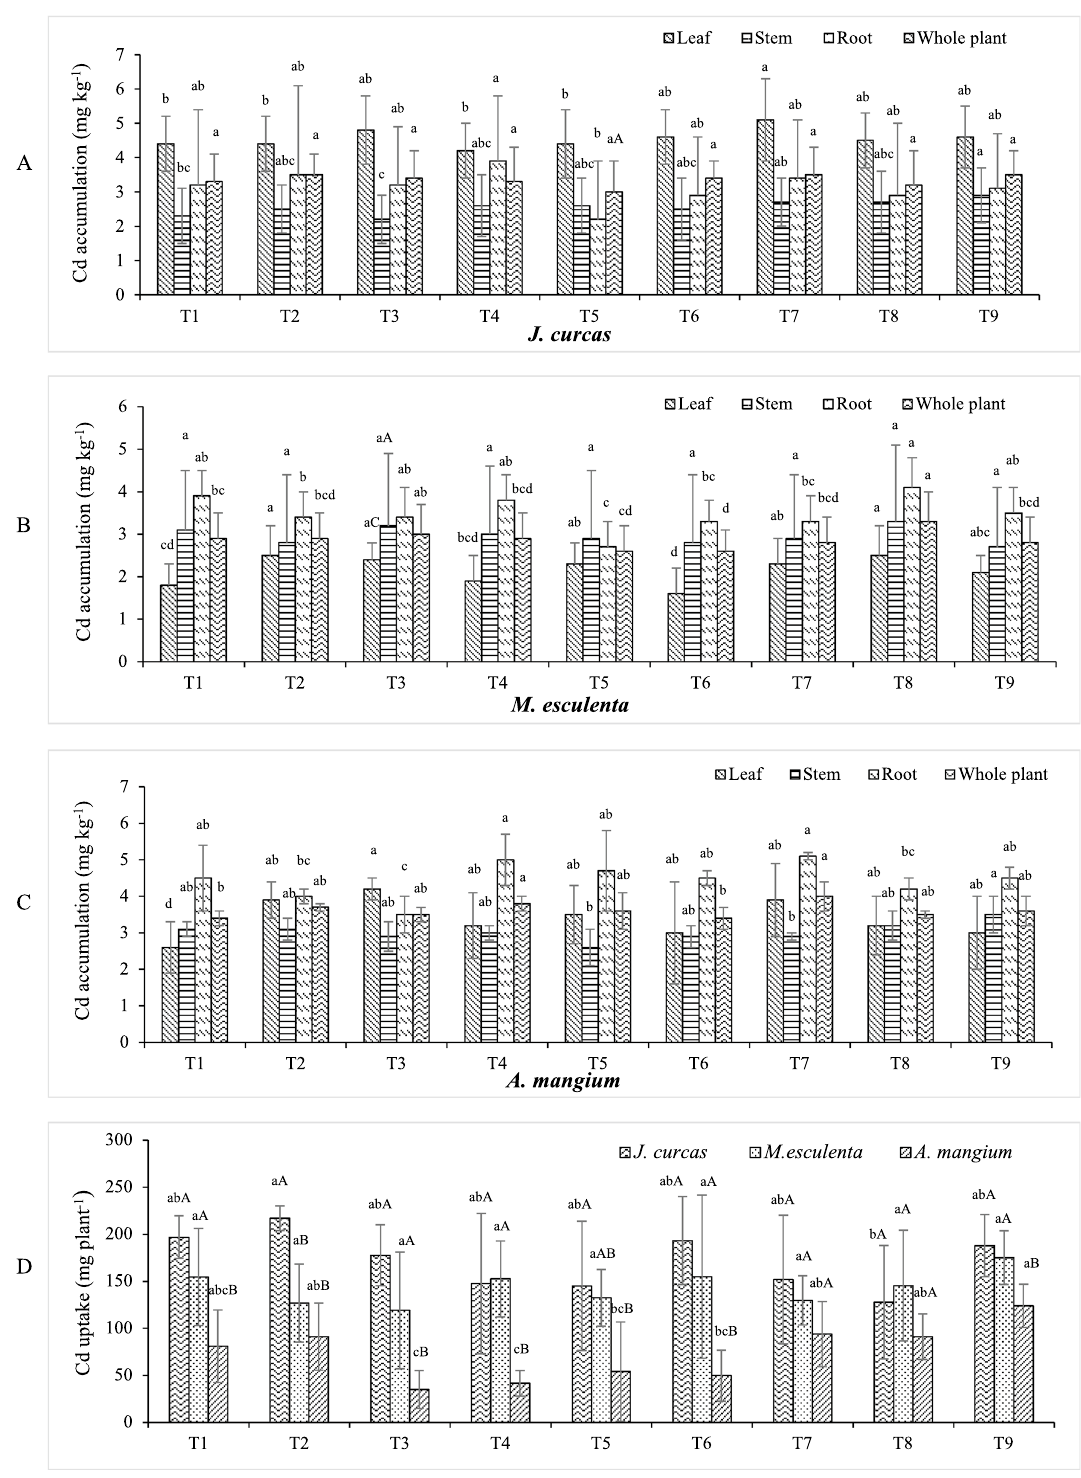
Figure 3. Cd accumulation and uptake among study plants, for 3 months ( n = 4). Values followed by the same letter are not significantly different; lower-case letters indicate the difference of values in Cd uptake among treatments within the same plant species (LSD, p < 0.05); capital letters indicate the difference of values in Cd uptake among plant species within the same treatment (LSD: p < 0.05). T1 = SL, T2 = SBM, T3 = SLBM, T4 = SLVC, T5 = LCM, T6 = LBM, T7 = BMVC, T8 = BMCM, T9 =